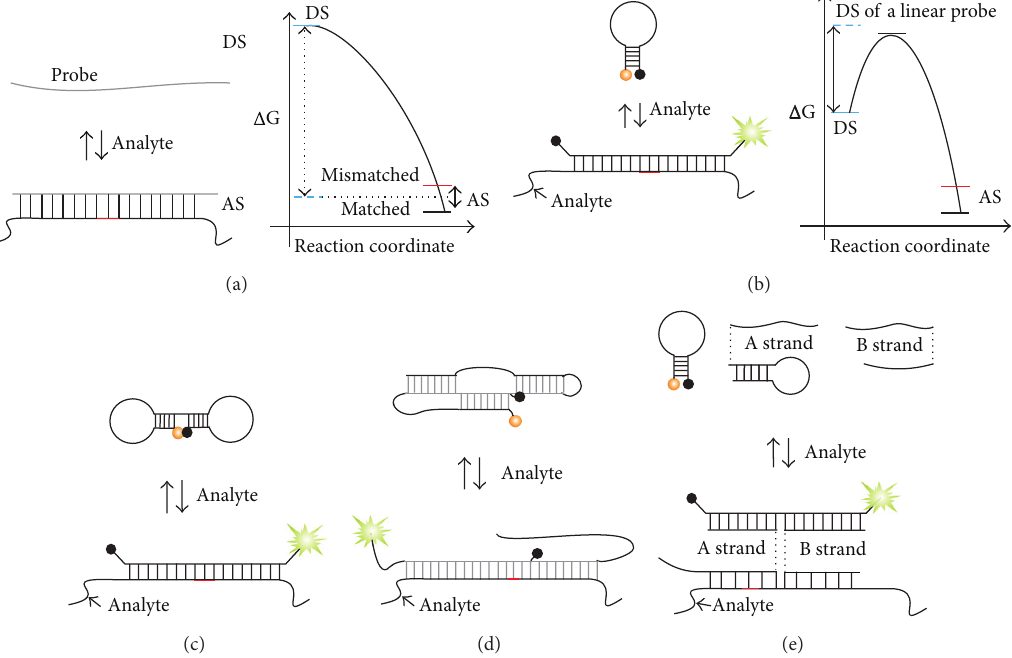
F 7: Schemes and energy diagrams for hybridization probes. (a) Hybridization of a linear oligonucleotide probe. “DS” and “AS” stand for probe-analyte-dissociated and -associated states, respectively. e difference in the energy between matched and mismatched duplexes is much smaller than the energy gap between DS and AS. (b) Hybridization of the MB probe. e energy of DS is reduced due to the formation of a 4–7-nucleotide stem. e maximum on the energy curve corresponds to the DS of the MB probe with unwound stem. (c) Dumbbell MB probe contains two stem loop elements in its structure. (d) Triple-stem probe has three stem structures. (e) Hybridization of MB-based X sensor. X sensor of Figure 6 was equipped with an additional stem-loop in the analyte-binding arm of within an SNP